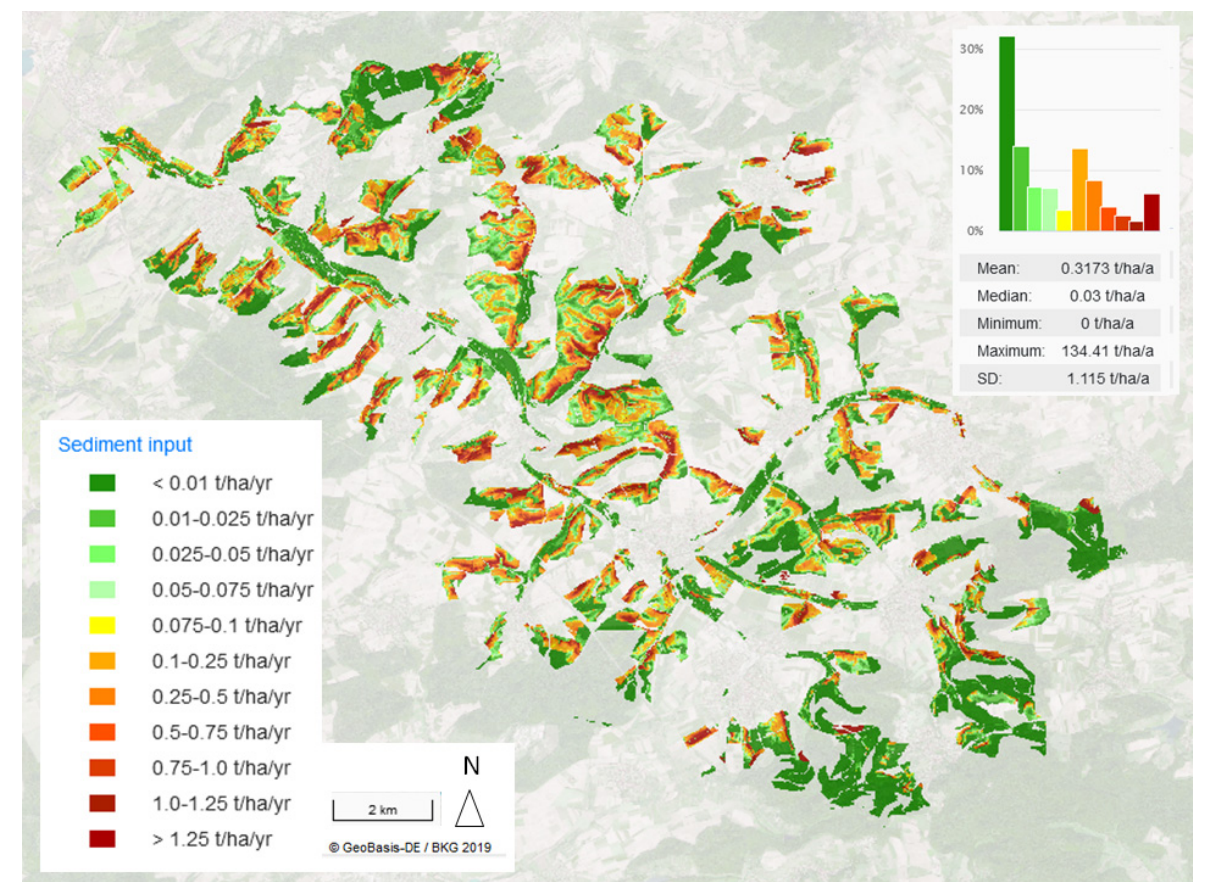
Figure 8. Modeled sediment input in the Kraichbach catchment.